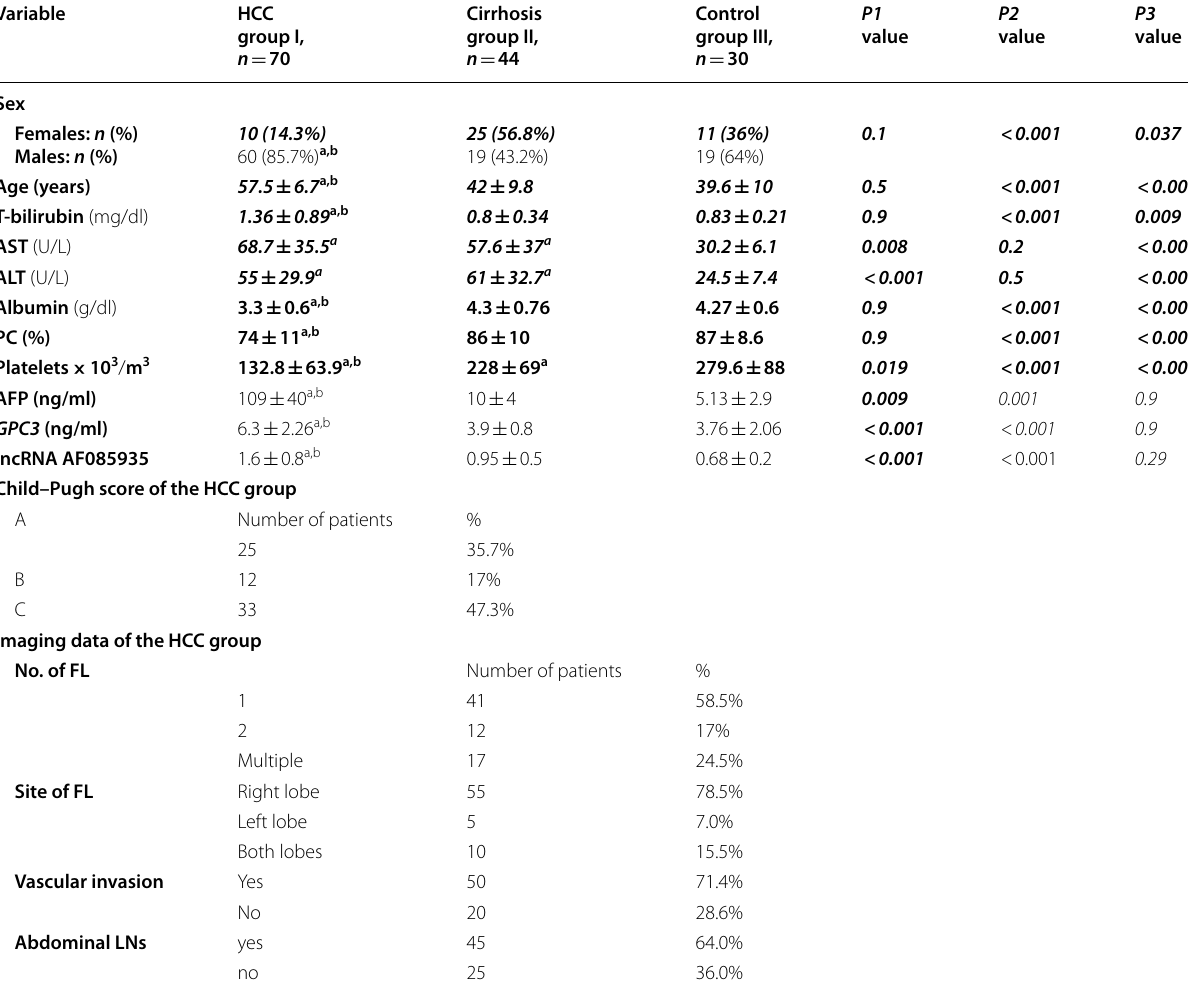
Table 1 Demographic and biochemical laboratory data among the studied